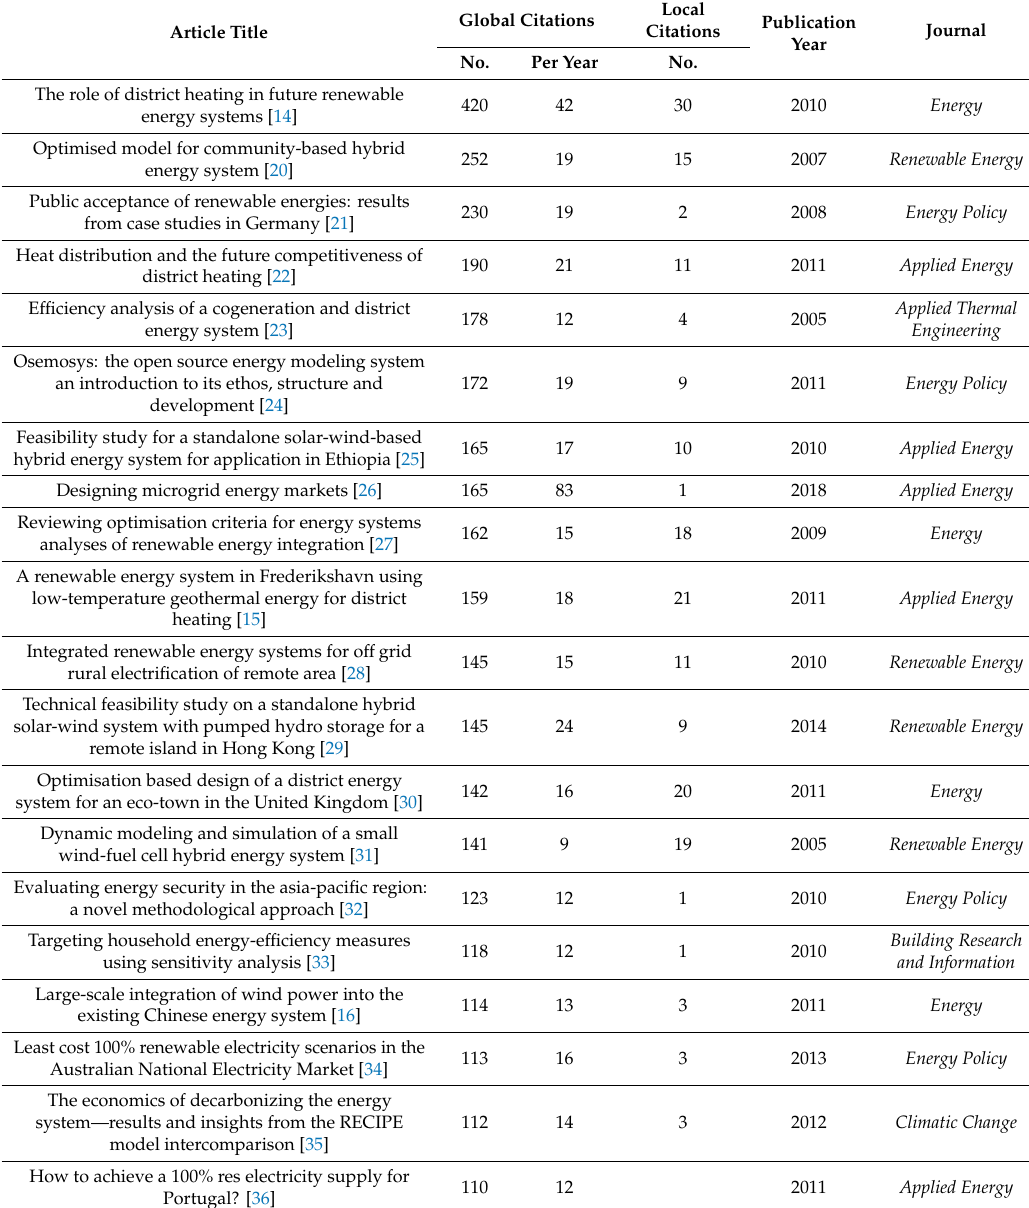
Table 7. Most frequently cited articles among the scientific contributions on municipal energy system planning.